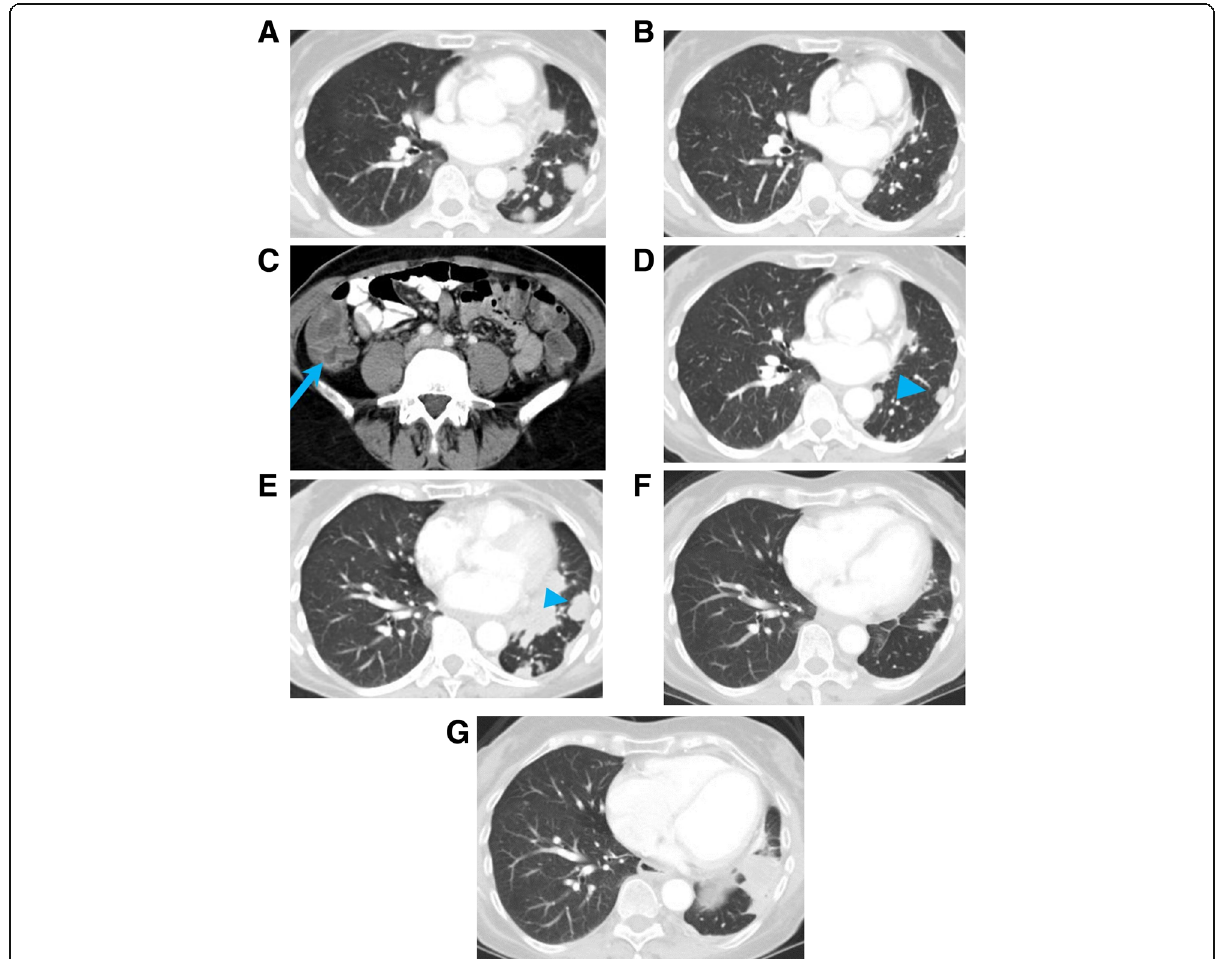
Fig. 11 A 68-year-old nonsmoker woman with non-small cell lung cancer, with EGFR exon 19 deletion. Baseline CT of the chest ( a ) shows multiple lung nodules, which shrunk after 3 months of treatment with the EGFR inhibitor erlotinib ( b ). While on treatment, patient developed diarrhea, and CT of the abdomen acquired during portal venous phase showed fluid filled large bowel, consistent with drug induced colitis (arrow) ( c ). After 4 years of treatment, CT of the chest ( d ) showed a new left lower lobe nodule, which markedly increased in size in 3 months (arrowhead) ( e ). Biopsy of the nodule showed acquired T90M mutation, which confers resistance to erlotinib. Patient was switched to osimertinib, with initial improvement of the lung nodules on follow-up chest CT ( f ). Tumor burden remained stable for 2 years, until a chest CT scan showed increased right lower lobe nodule ( g ). Patient was then switched to